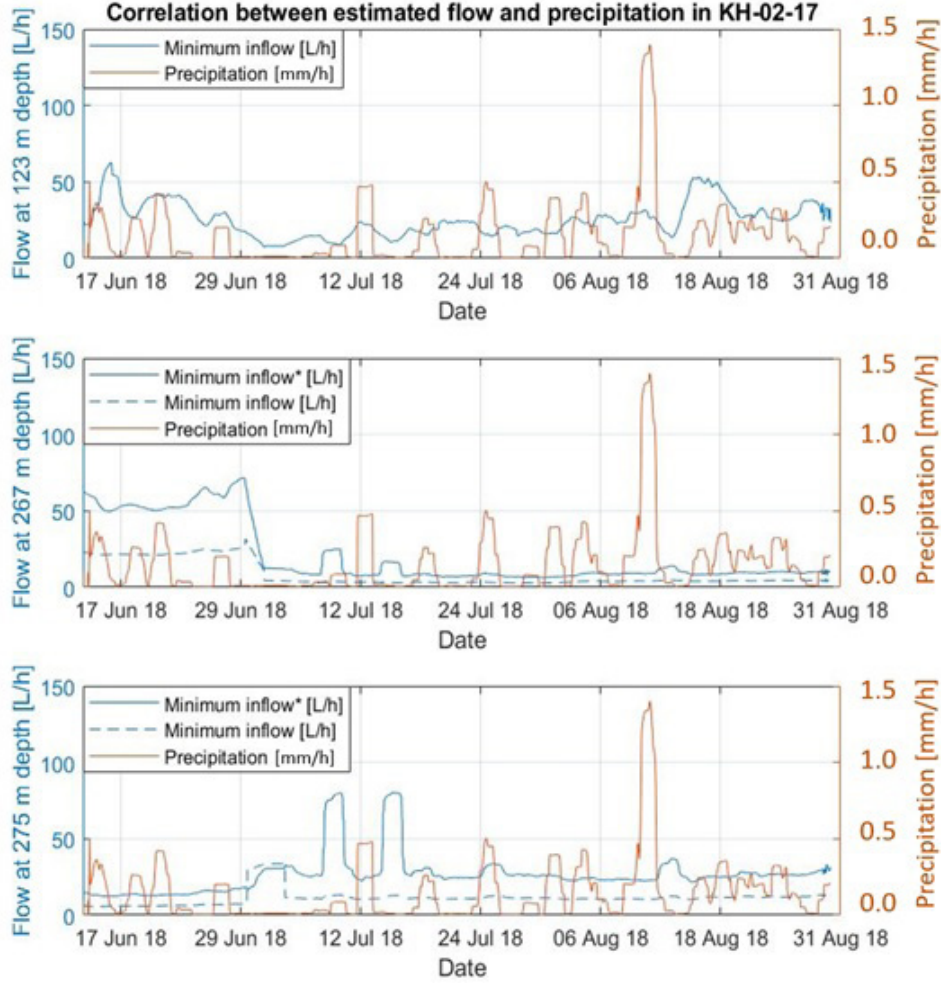
Figure 7. Correlation between moving, average (daily) groundwater flow estimation at 123, 267 and 275 m depth in KH-02-17 and daily precipitation: the precipitation data are adjusted by 1.0, 1.1 and 0.9 days, which gives a correlation factor with precipitation of 0.17, 0.16 and 0.17 for the fractures in decreasing